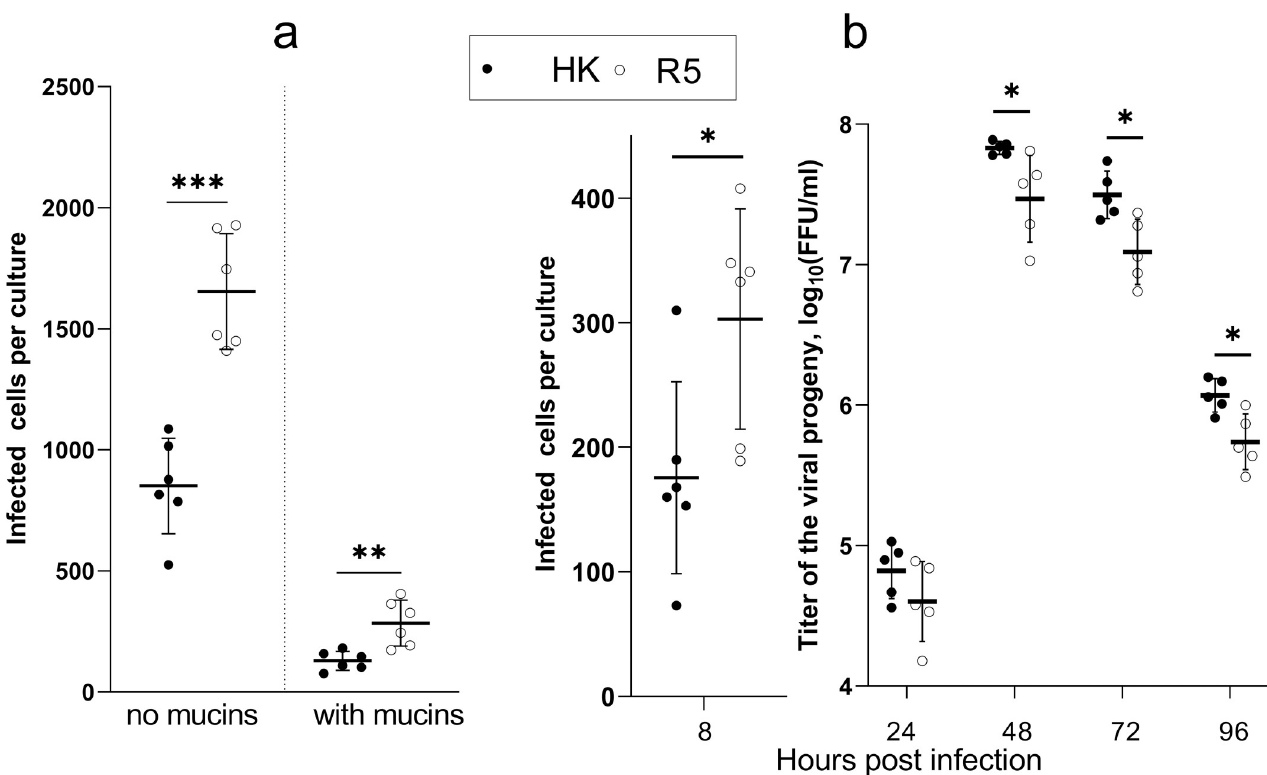
Fig 7. Infectivity and multicycle replication of HK and R5 in HTBE cultures. ( a ) The apical sides of HTBE cultures were washed with PBS+ to remove mucins and inoculated with 2x10 4 FFU of HK (closed circles) and R5 (open circles) with and without addition of mucins using 6 replicate cultures per condition. The inoculum was removed after 1 h. The cultures were incubated for 7 h under ALI conditions, fixed, immuno-stained for viral NP, and numbers of infected cells were counted. ( b ) The apical sides of washed HTBE cultures were inoculated with 7x10 4 FFU of the viruses without addition of mucins and processed as described above. Six cultures per virus were fixed 8 h post infection for immuno-staining and counting of infected cells. Viral progeny was periodically harvested by washing the apical sides of the remaining cultures, and the harvests were titrated simultaneously at the end of the experiment. P values were determined using Student’s